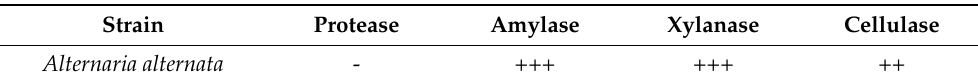
Table 2. Enzymatic activities of Alternaria alternata : Undetectable enzyme (-), halo 5 mm (++), and halo > 5 mm (+++).